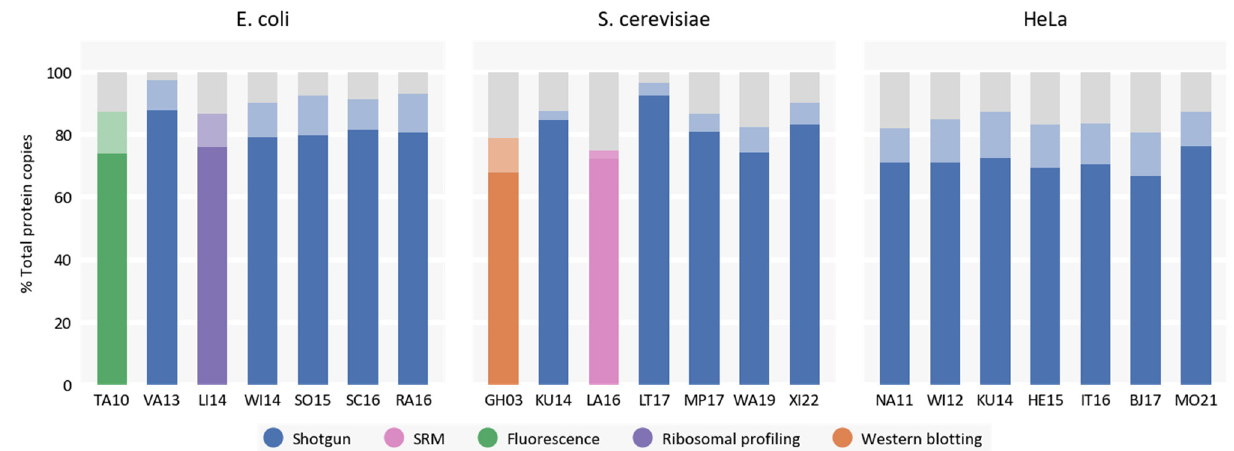
Figure 2. Contribution of proteins quantified in all untargeted datasets for a particular model organism (core proteins) to the reported total protein copy numbers as a percent of total copies. Less saturated portions of the bars represent contributions of proteins which are present in at least n – 1 untargeted dataset for a particular model organism (core 1) to total protein copies.